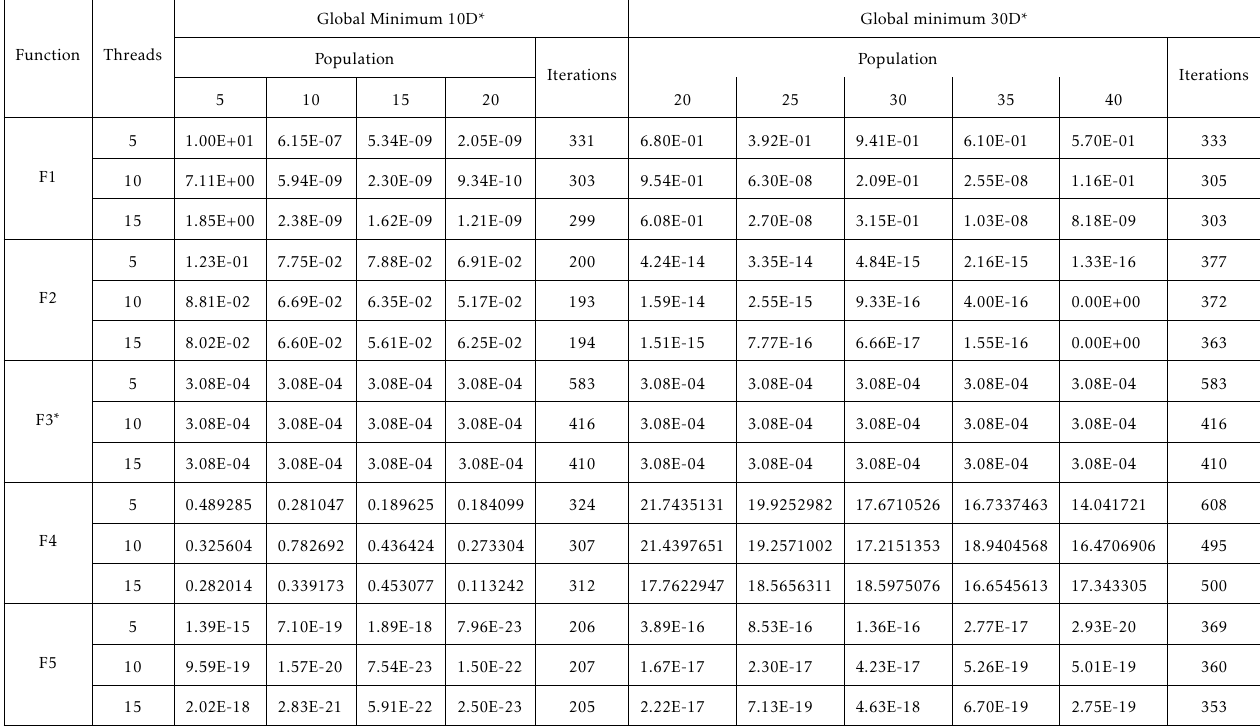
Table 9. RFO performance results in parallel with simulated annealing restart to the best method